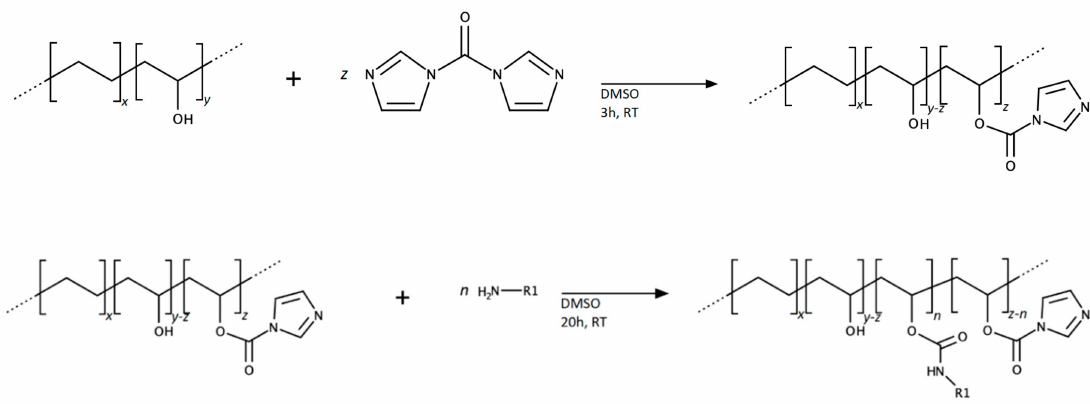
Figure 2. Scheme of the synthetic pathway for the preparation of the random copolymer DFO@ ethylene-vinyl alcohol copolymer (EVOH) or 3,4-HP@EVOH. R1-NH 2 can be a DFO / Fe(III) or 3,4-HO / Fe(III) complex. EVOH 32%: 0.50 g; DMSO: 10 mL; carbonyldiimidazole (CDI): 0.70 g; DFOm / 3,4-HO: 0.10 g; Fe(NO 3 ) 3 : 0.04